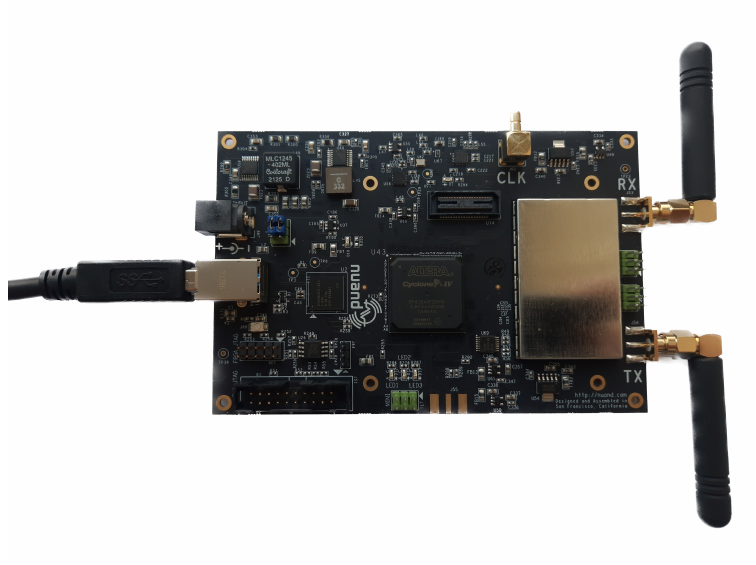
Figure 5. SDR BladeRFx40 used for our